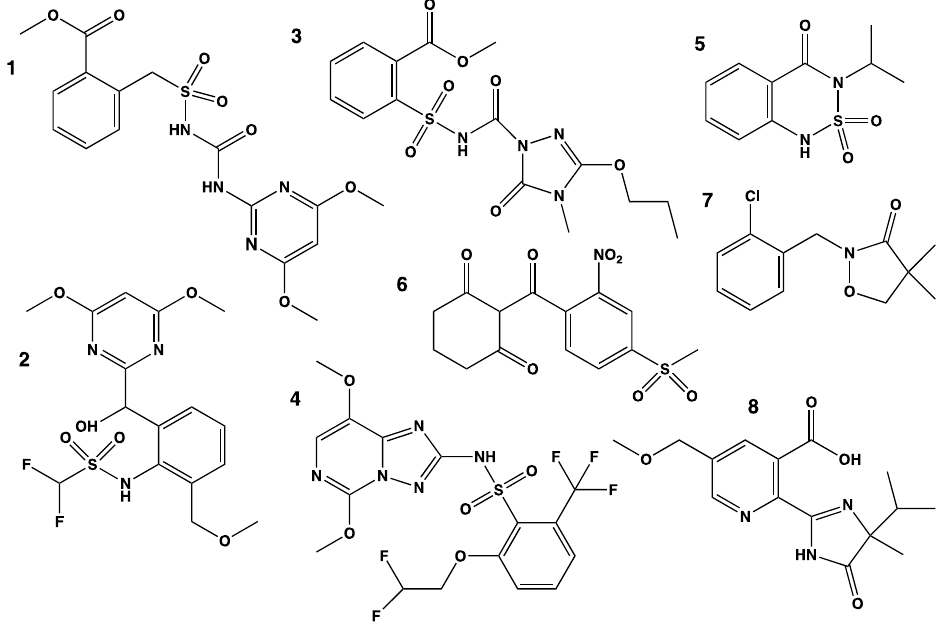
Figure 4. Representative members of the herbicide chemical groups metabolized by CYP81A12 and its paralogs of Echinochloa phyllopogon . Only one member of each chemical class is represented. Sulfonylurea are the best substrates, and among them bensulfuron-methyl is the most actively metabolized. The different CYP81A paralogs have different substrate preferences. The sites of the oxidative attacks leading to hydroxylation or demethylation have not been determined: 1 : bensulfuron-methyl (sulfonylurea); 2 : pyrimisulfan (pyrimidinyl(thio)benzoates); 3 : propoxycarbazone (sul-